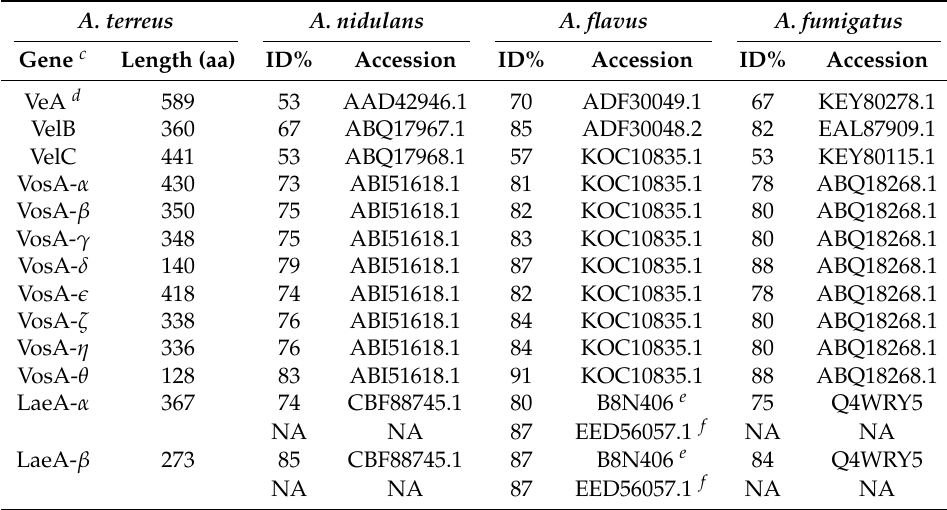
Table 1. Residue identity a of A. terreus velvet family members to A. nidulans , A. flavus and A. fumigatus orthologs b